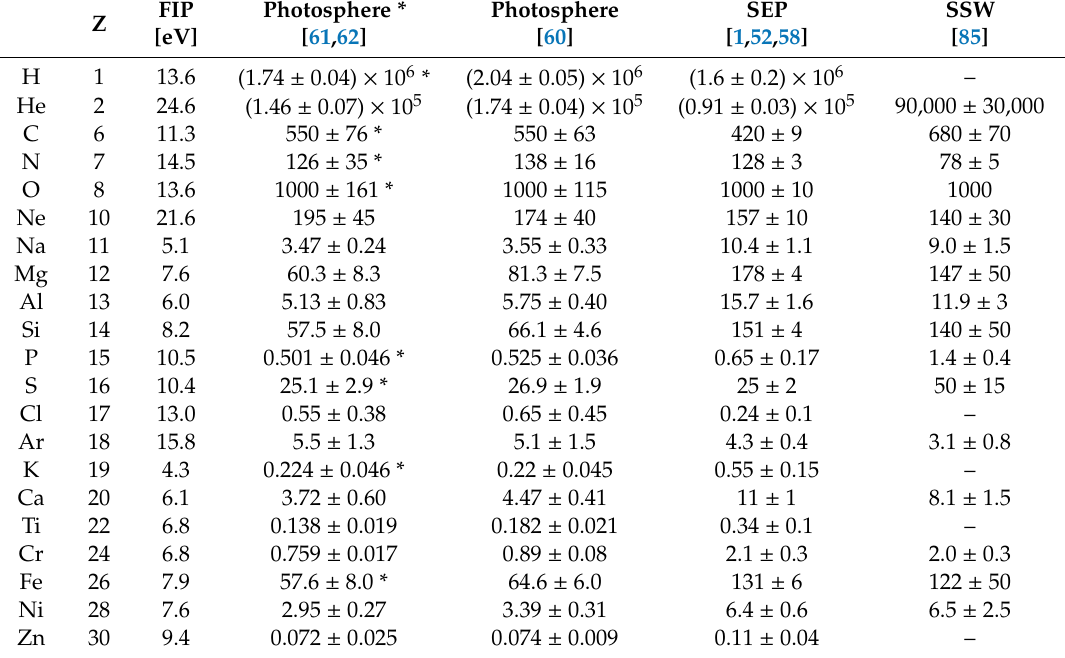
Table A1. Element Abundances of the Photosphere and of the Corona as measured by SEPs and the SSW. FIP